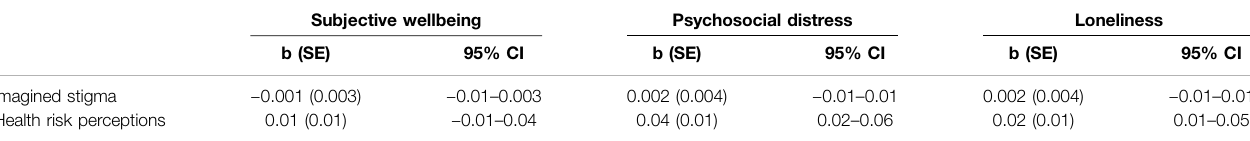
TABLE 4 | Indirect effect of media use on mental health distress for each hypothesized